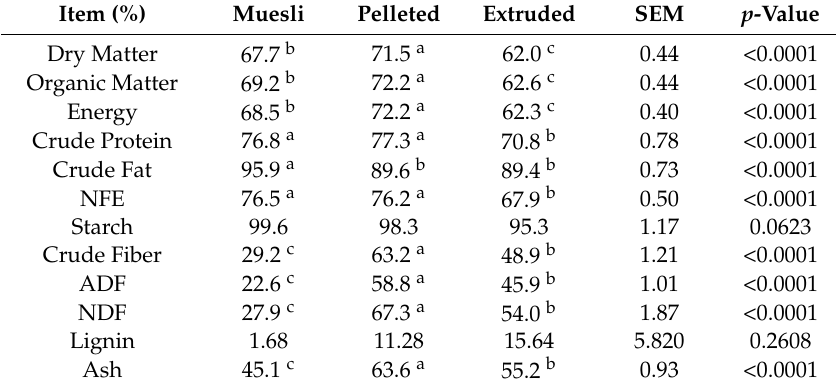
Table 5. Digestibility of muesli, pelleted, or extruded dietary treatments fed to rabbits and determined by acid insoluble ash as an internal marker to calculate apparent total tract digestibility